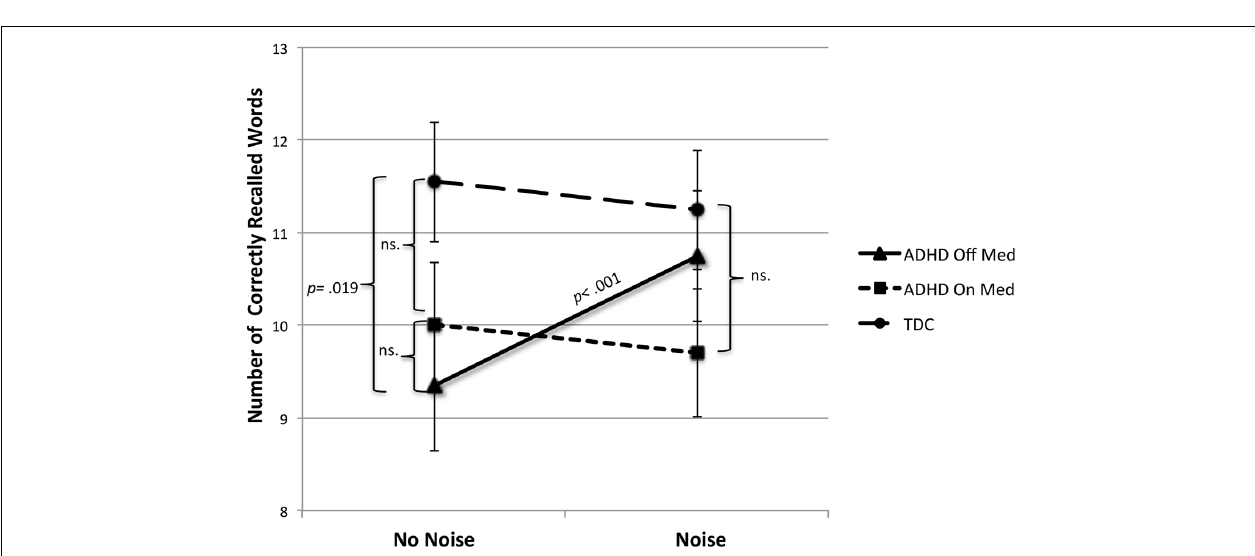
FIGURE 2 | Number of correctly recalled words as a function of medication and noise in ADHD. As a comparison the performance of TDC is shown as a function of noise; test occasion is counterbalanced for the TDC group. White noise 79–80 dB; TDC, typically developed children; p -values are written in the graph for significant